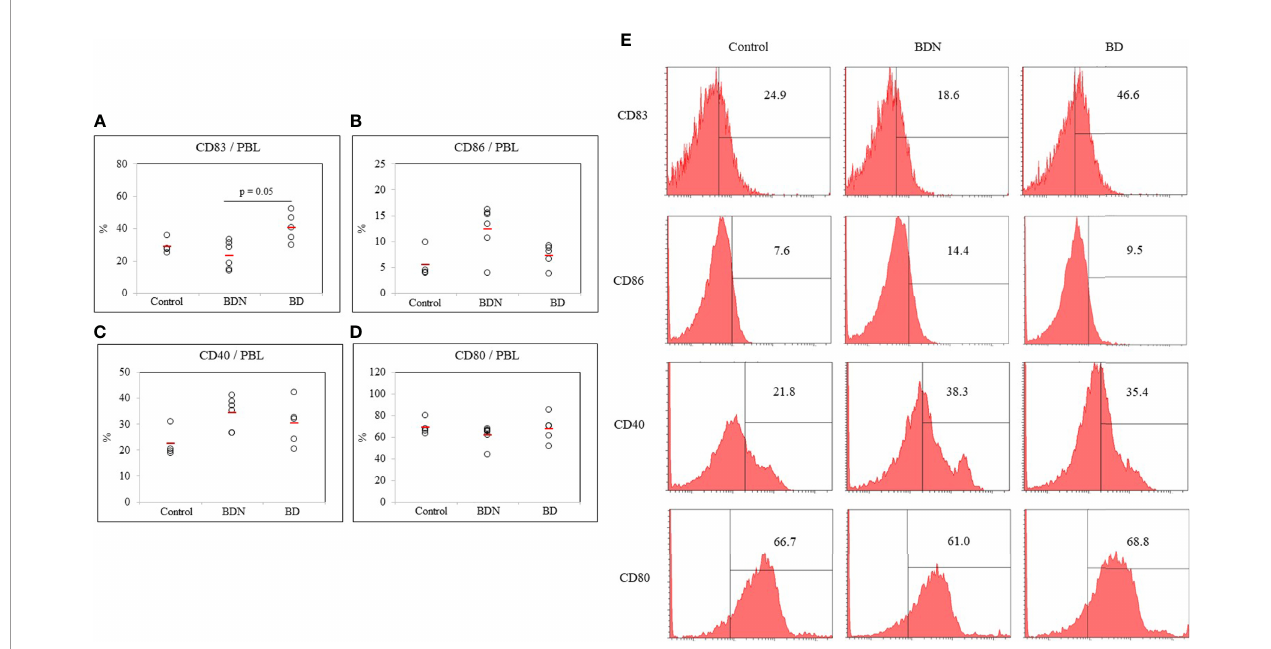
FIGURE 3 | The frequency of DC costimulatory molecules CD83, CD86, CD40, and CD80 (A – D) in whole PBL was assessed in normal, BDN, and BD mice. Isolated PBL were surface stained and evaluated by fl ow cytometry. A representative histogram of CD83+ cells is shown in (E) . For statistical analysis, the Kruskal- Wallis test was performed using GraphPad. The number of mice used in the experimental groups was fi ve in the normal, six in the BDN, and fi ve in the BD group. The experiments were performed independently at least three